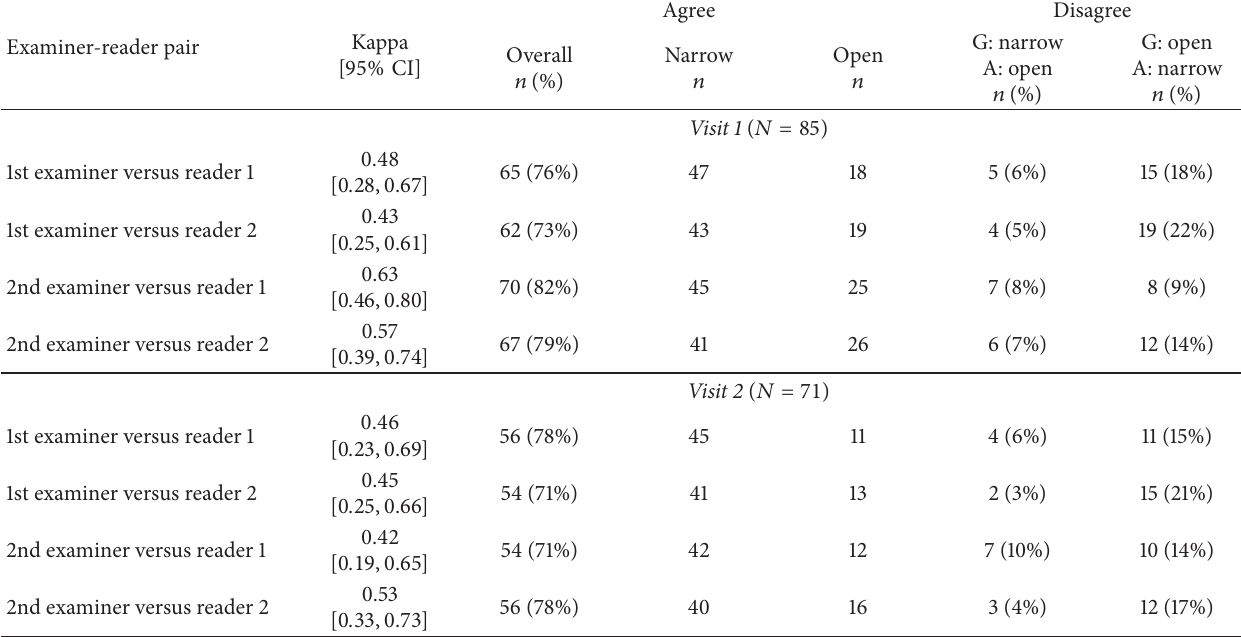
Table5:Agreement(%)betweenpairsofgonioscopicexaminersandFourierdomainanteriorsegmentopticalcoherencetomographyreaders at each